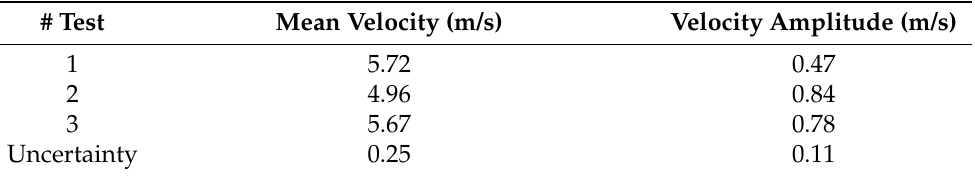
Table 2. Uncertainty evaluation for the 5 m/s